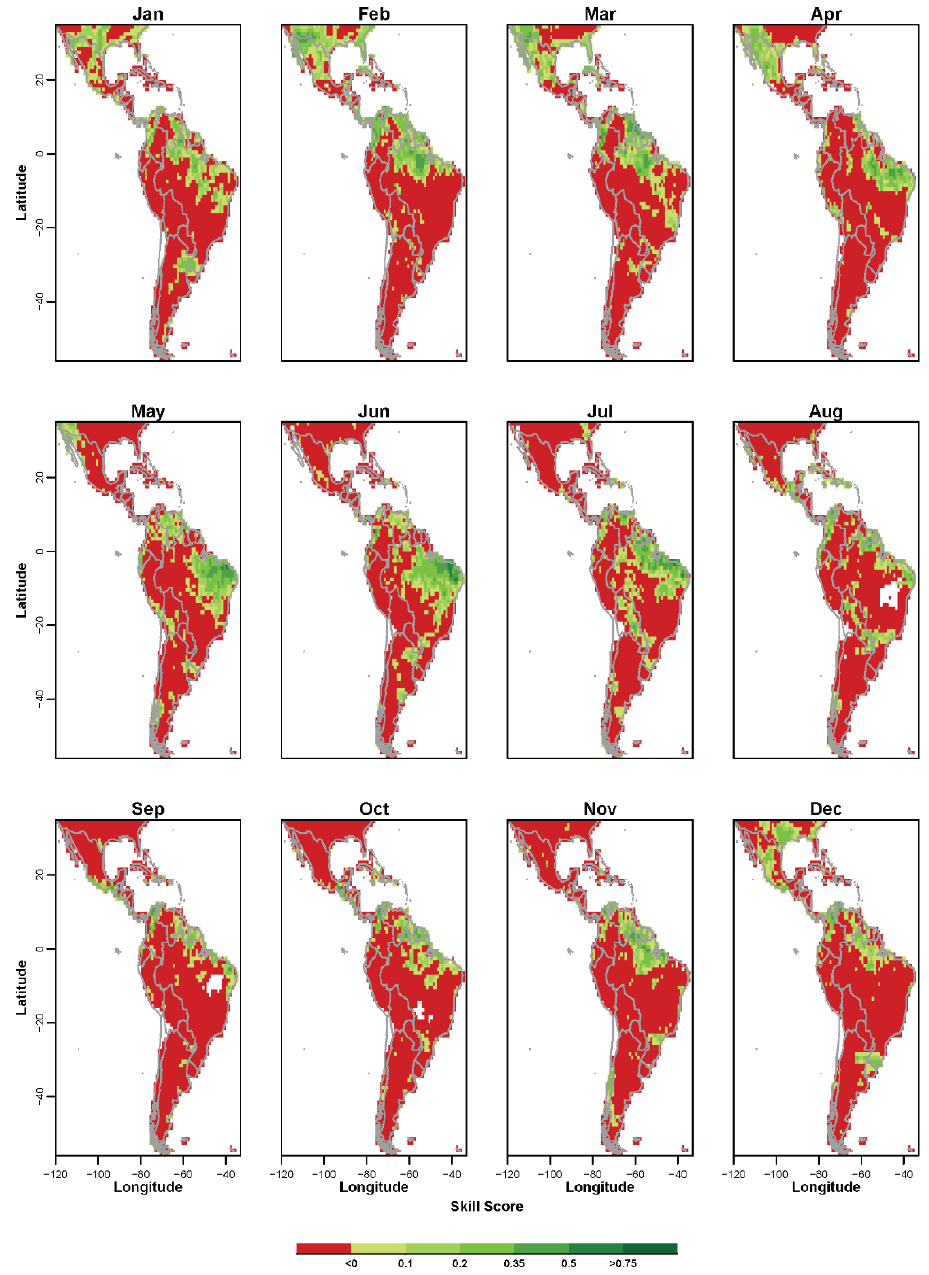
Figure 4. Skill Score of the SPI3 at 3-month lead time forecast measured in terms of the RMSE relative to climatological RMSE for the hindcast period (1981–2010).